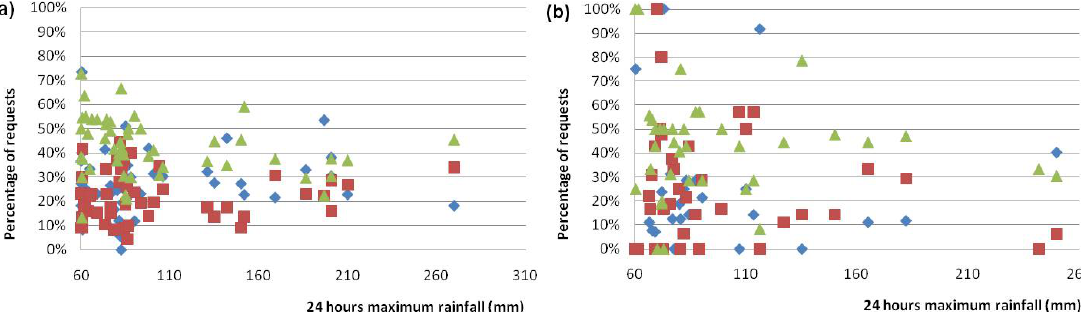
Fig. 6. Interrelation between the percentage of requests in the periods discussed in the text and the maximum rainfall recorded in 24h during each SIR event for: (a) Catalonia and (b) the Balearic Islands. The percentage of requests received during the first 10days is represented by blue diamonds, from 10days to 1month by red squares, and from 1 to 6months by green triangles.